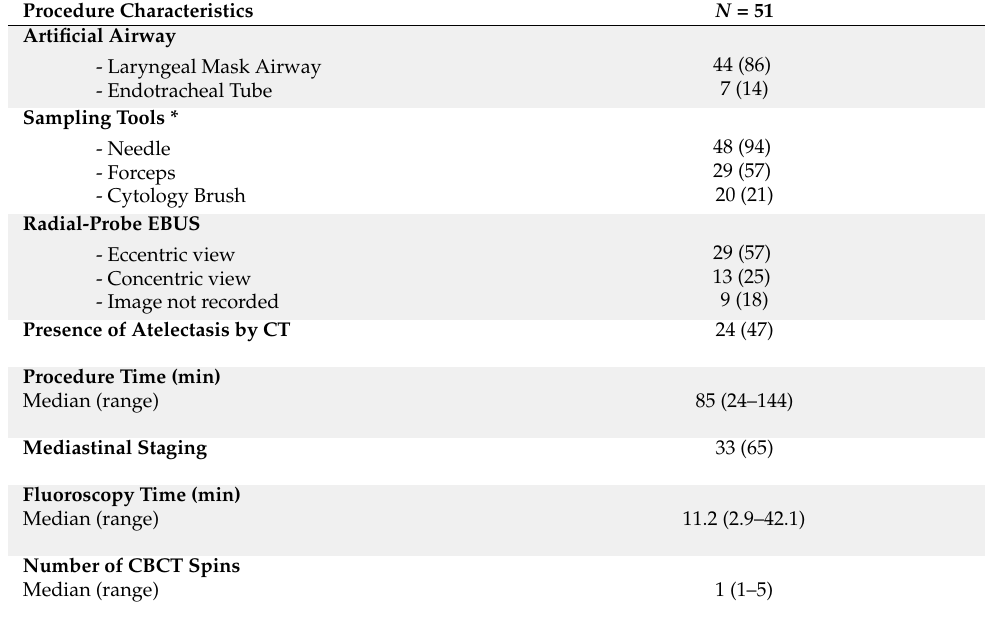
Table 2. Procedure Characteristics.